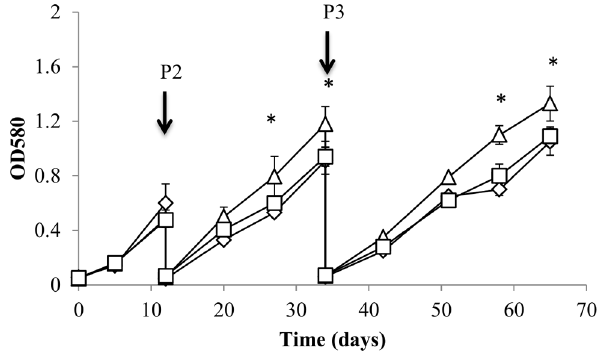
Figure 5. Growth of the DosR D strain is more robust during iron depletion. Bacterial growth was monitored over three passages (P1-3) in iron-depleted medium. Diamond – wild type strain; triangle – DosR D strain; square – DosR D complemented strain. Data are the mean and standard deviation from three independent cultures. * p , 0.05 using Student’s t-test comparing the DosR D and wild type strain.